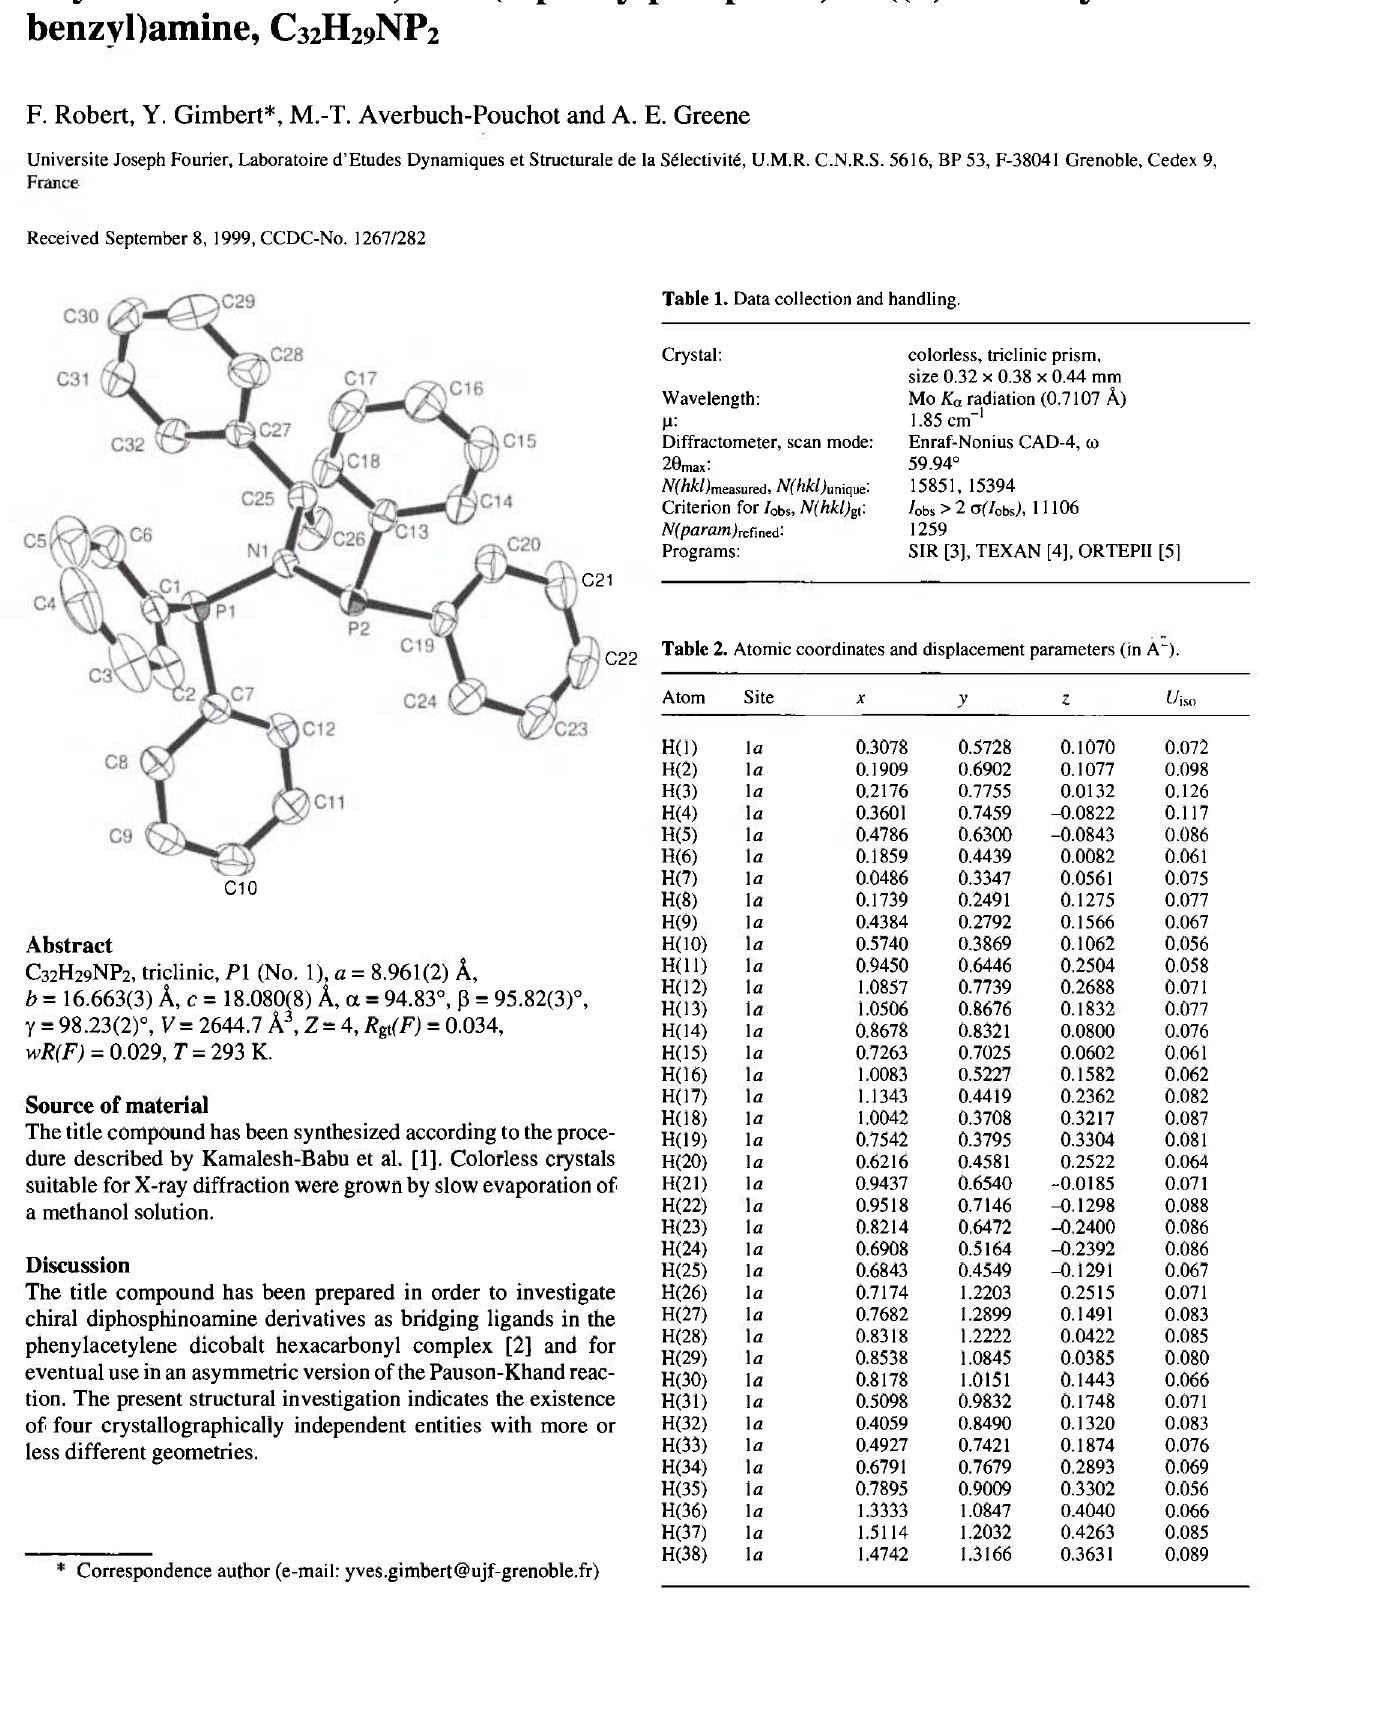
Table 1. Data collection and handling.